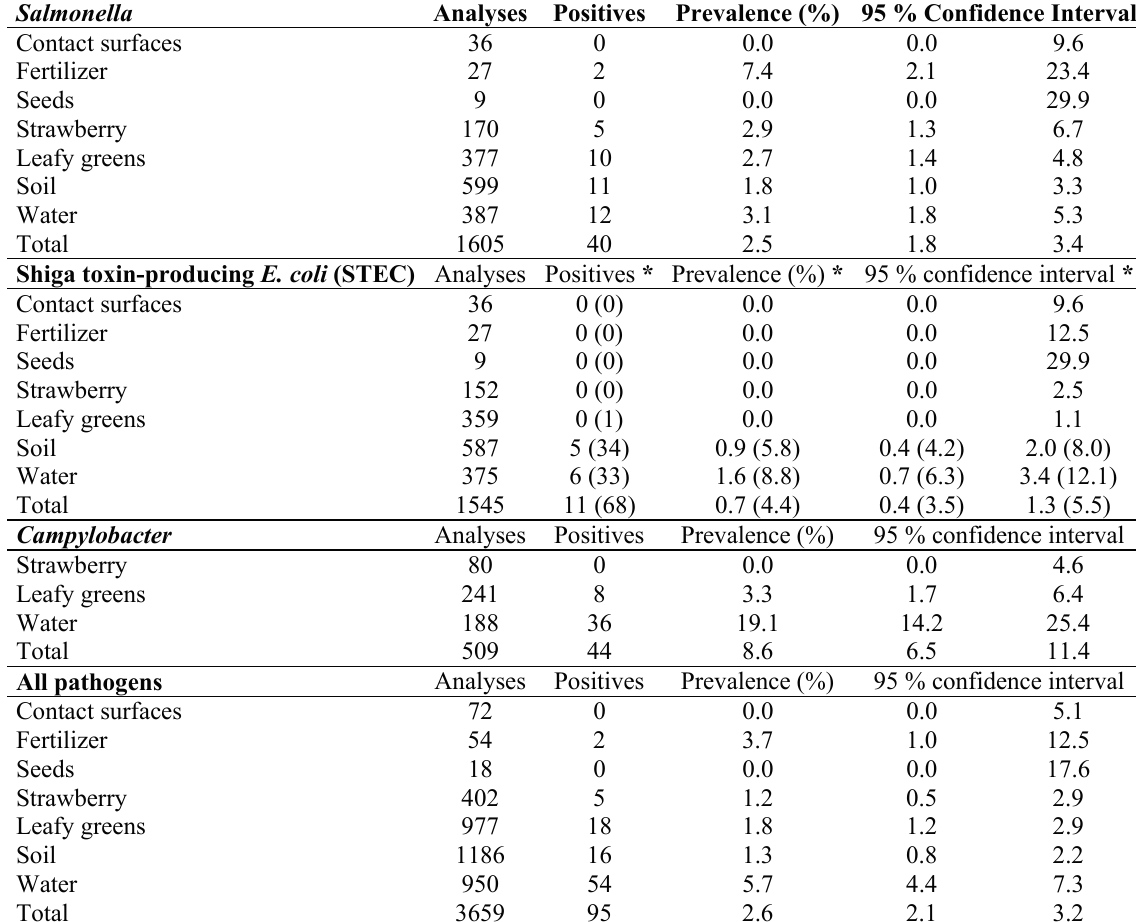
Table 2. Pathogen prevalence per sample